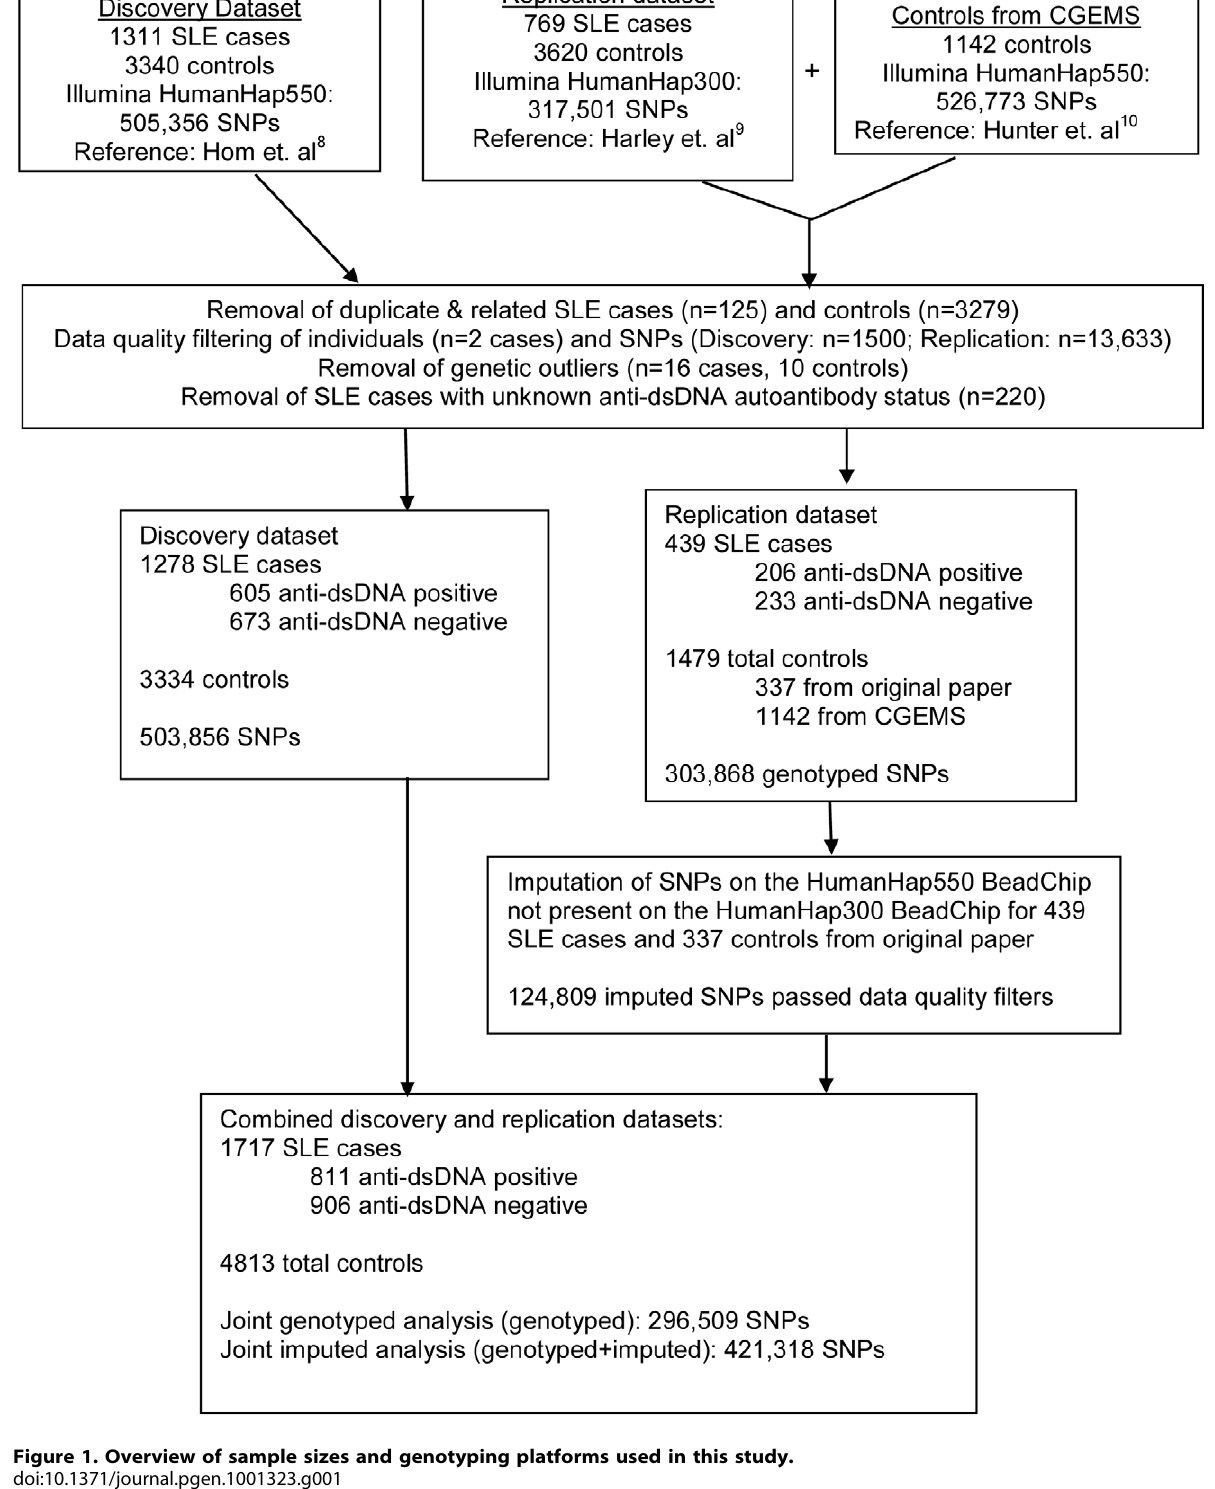
datasets. While SNPs in/near LAMC2 and COL25A1 met the genome-wide significance threshold in the discovery dataset, these associations were not observed in the replication dataset, possibly due to the limited statistical power of the second dataset.